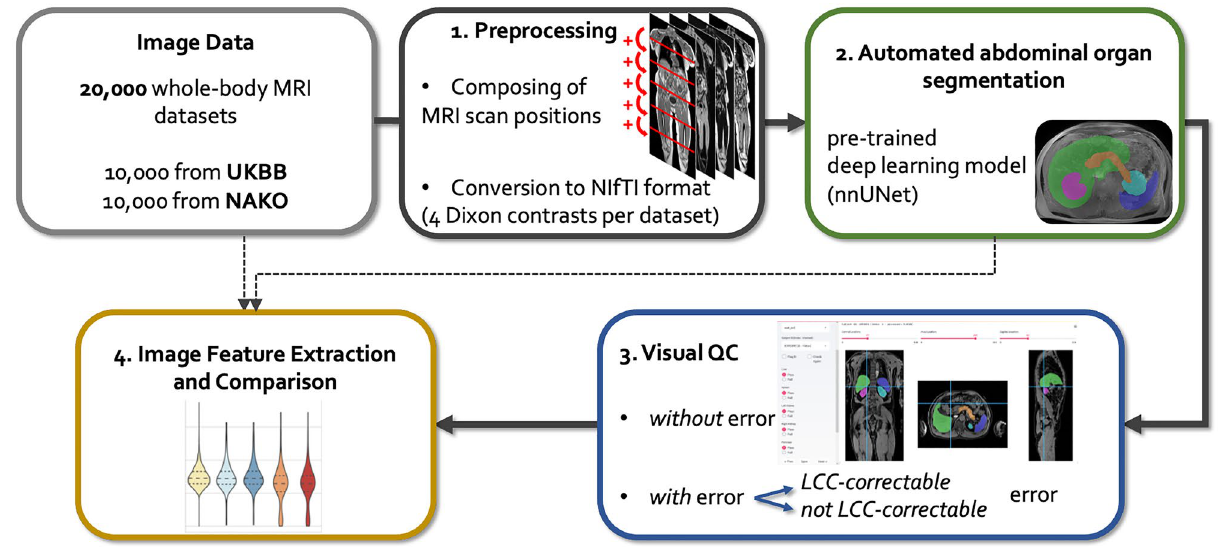
Figure 1. Summary of the data processing pipeline. In a first step (upper middle panel, black), image data from UKBB and NAKO were preprocessed by composing single MR acquisition stations and conversion to the NIfTI format. Subsequently (right upper panel, green) organs were automatically segmented on preprocessed image data. In a third step (lower right panel, blue), quality control of automated segmentations was performed visually and segmentation errors were categorized. Finally (lower left panel, yellow), shape features were extracted from image data based on organ segmentations. LCC = largest connected component.